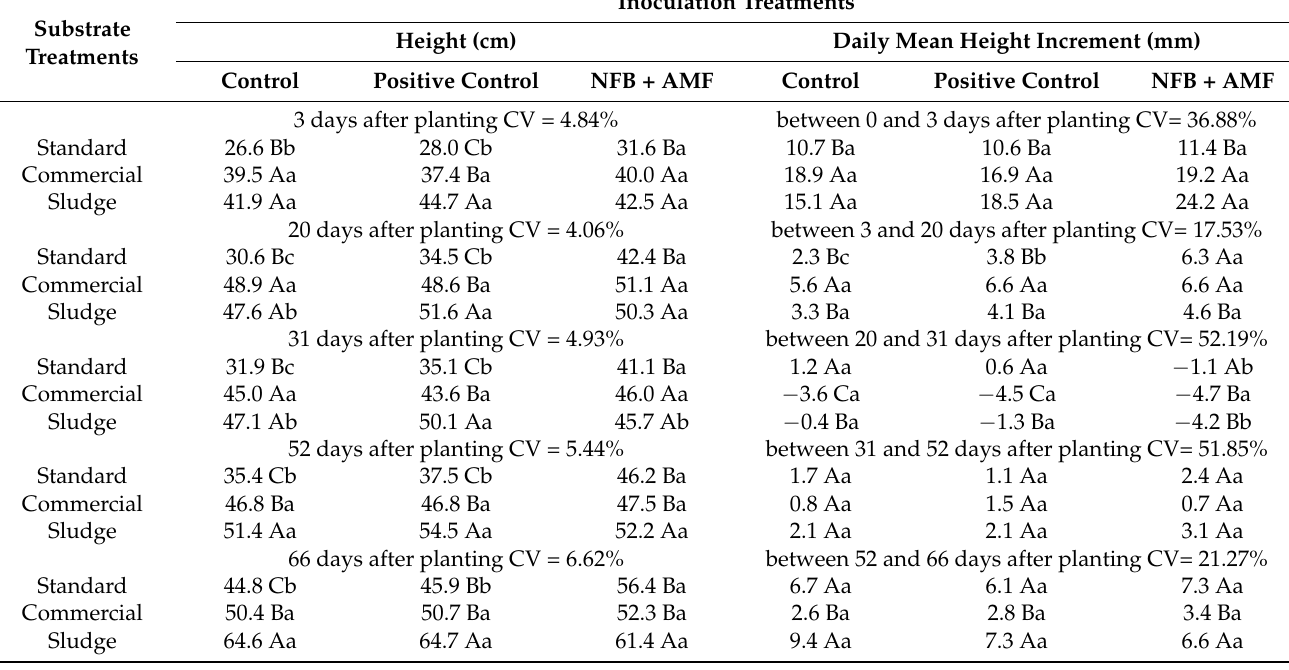
Table 5. Height total values and increment at 3, 20, 31, 52, and 66 days after planting Samanea saman seedlings produced with different inoculation patterns and substrates under water restriction (until the 36th day) and rehydration (after the 36th